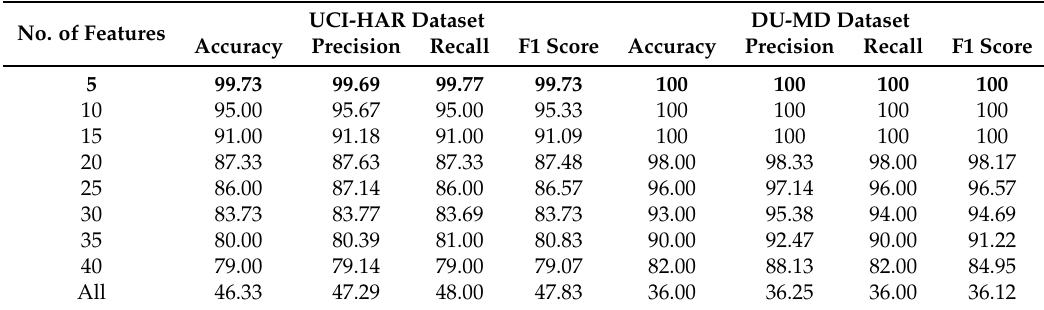
Table 3. Feature based performance (%) of the proposed model performing 3-fold Cross-Validation on both datasets.